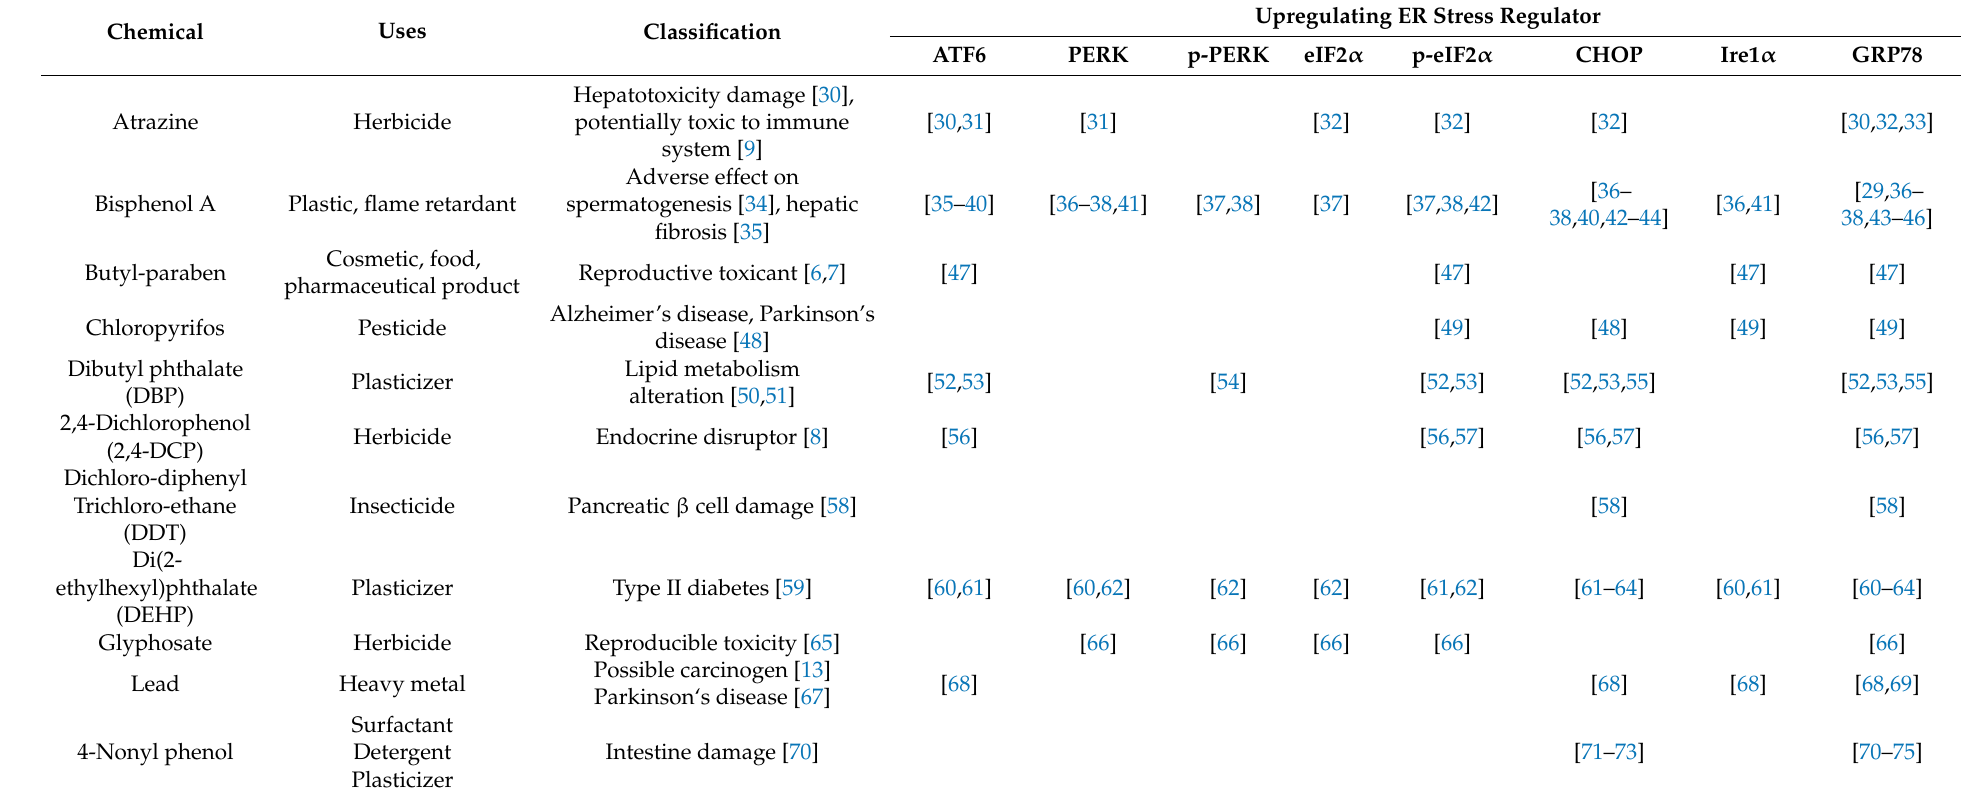
Table 1. Common EDCs and ER stress